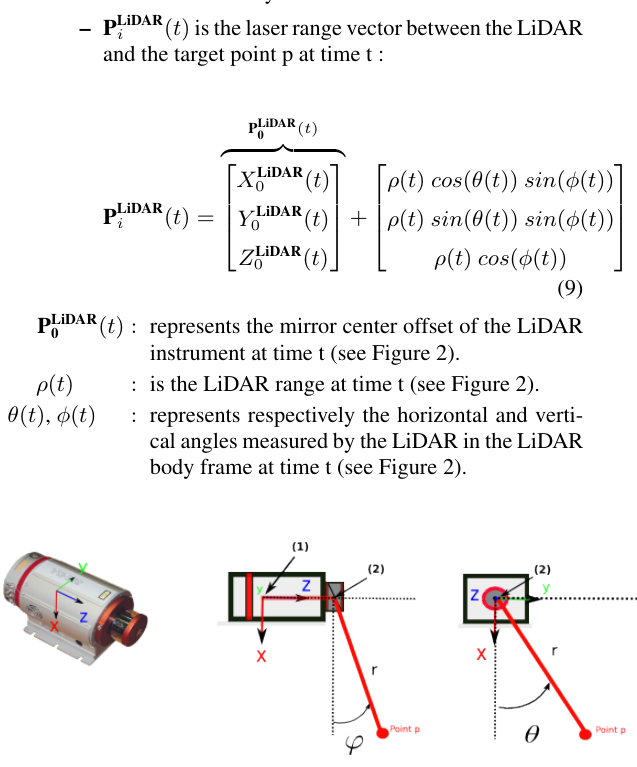
Figure 1: Concept of Mobile Terrestrial LiDAR System (MTLS) The formula used to calculate the LiDAR point in the world frame